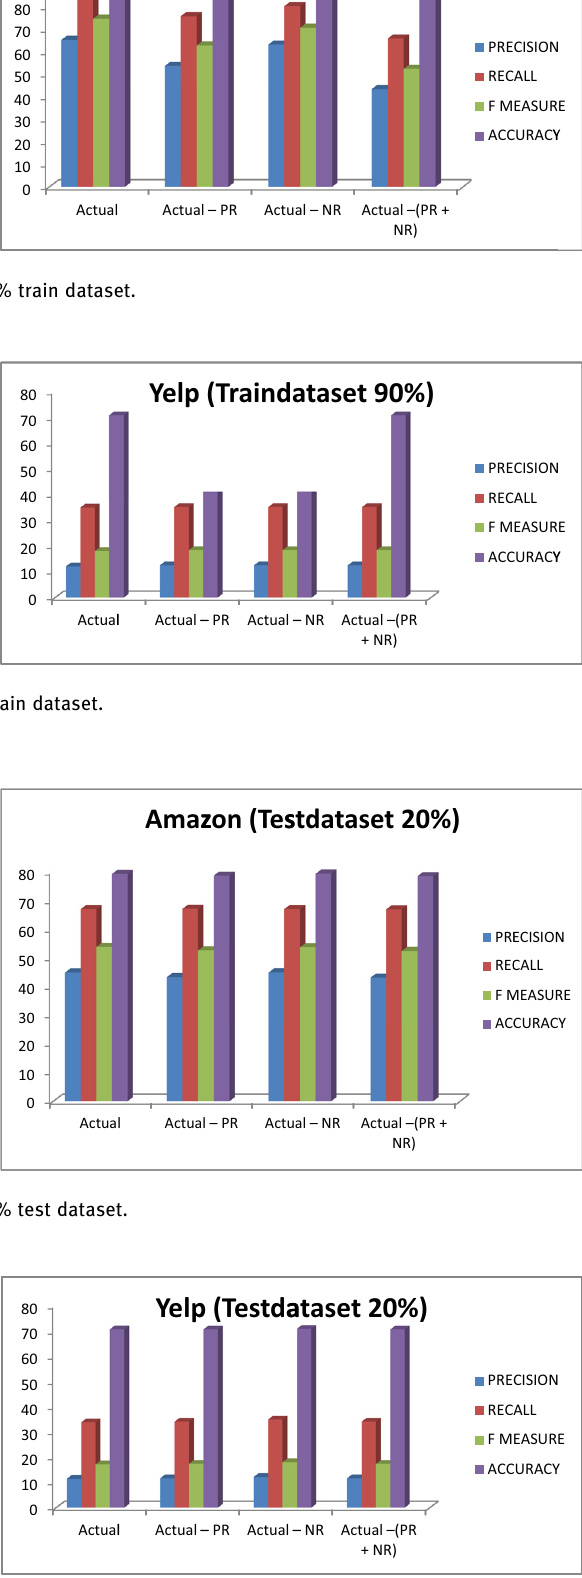
Figure 5: Plot for Yelp 20% test